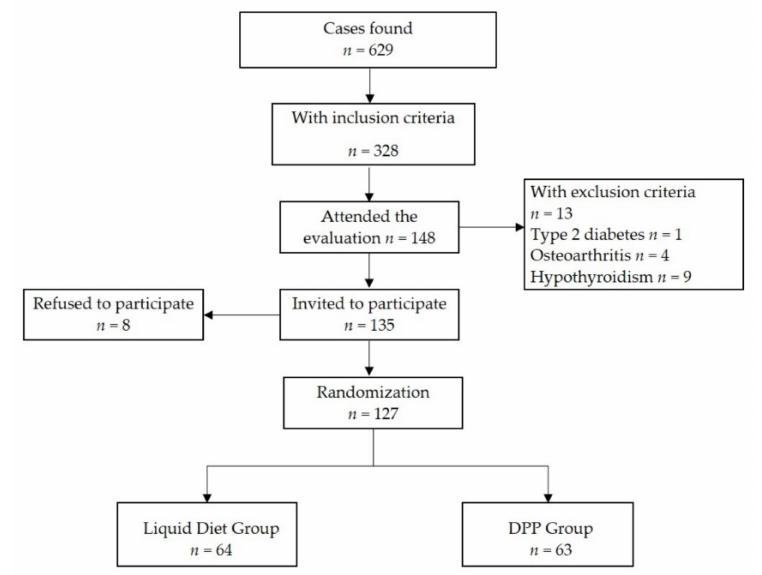
Figure 1. Flowchart of the study